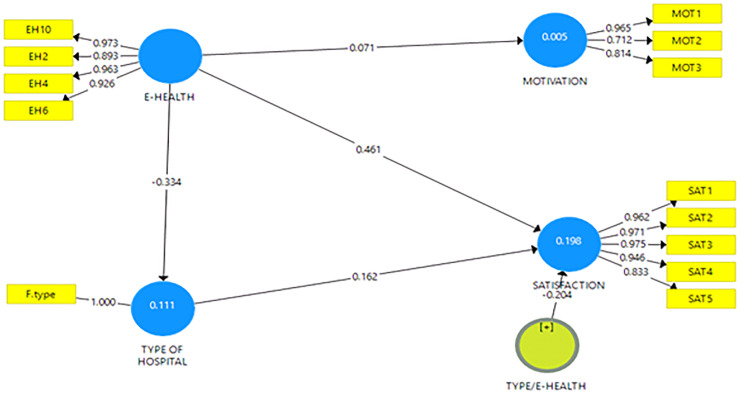
Tests statistics and path coefficients.